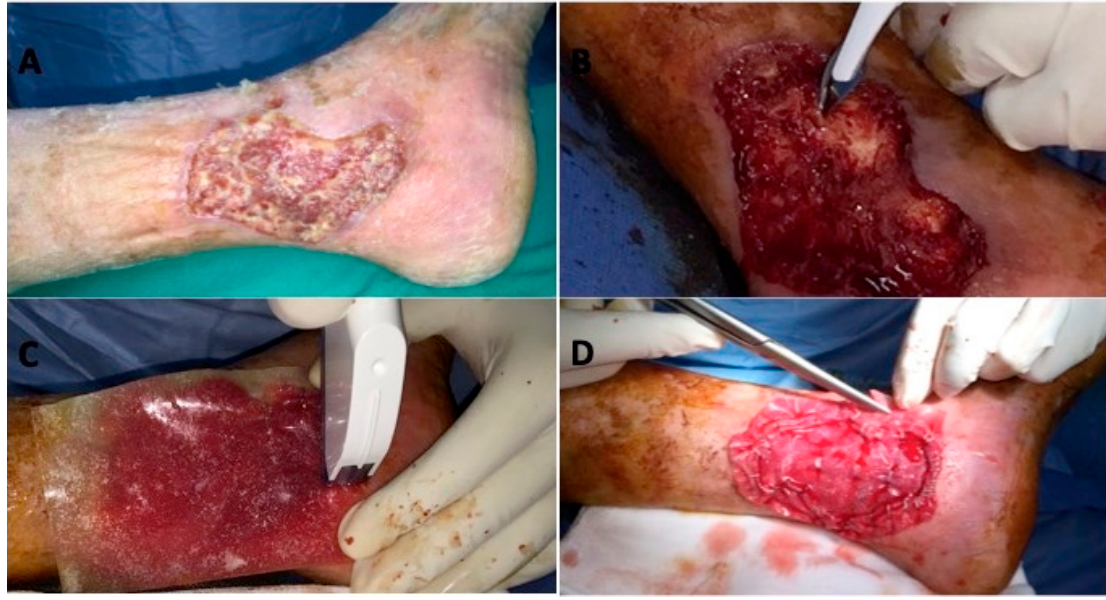
Figure 1. Surgical Protocol. A ) Vascular ulcer, pre-operative situation; B ) careful debridement; C ) implant of dermal substitute; D ) remodelling.